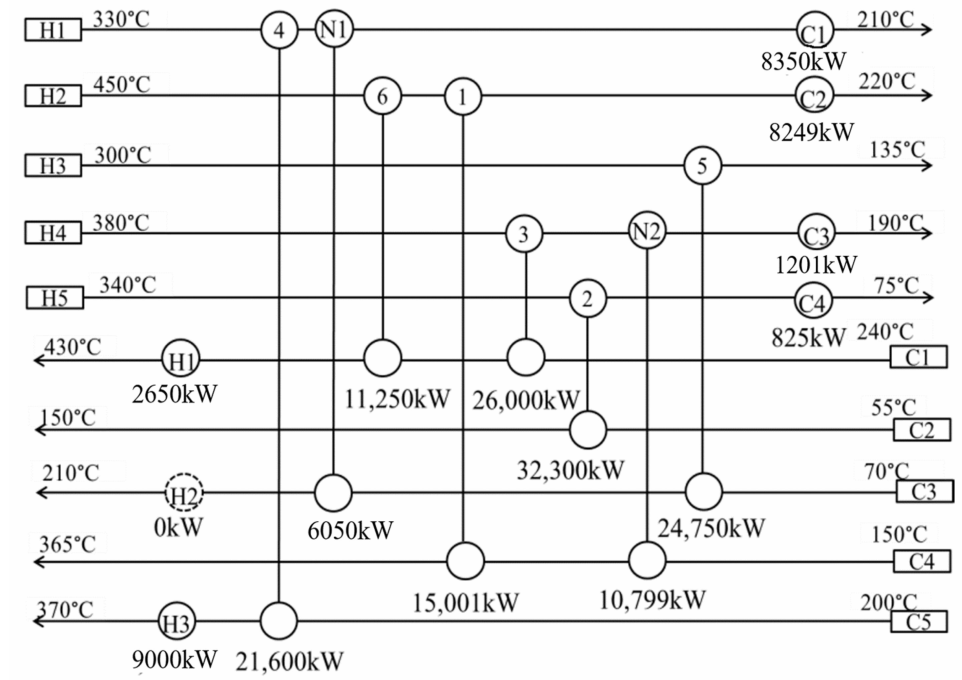
Figure 23. The best second modification for retrofit HEN.